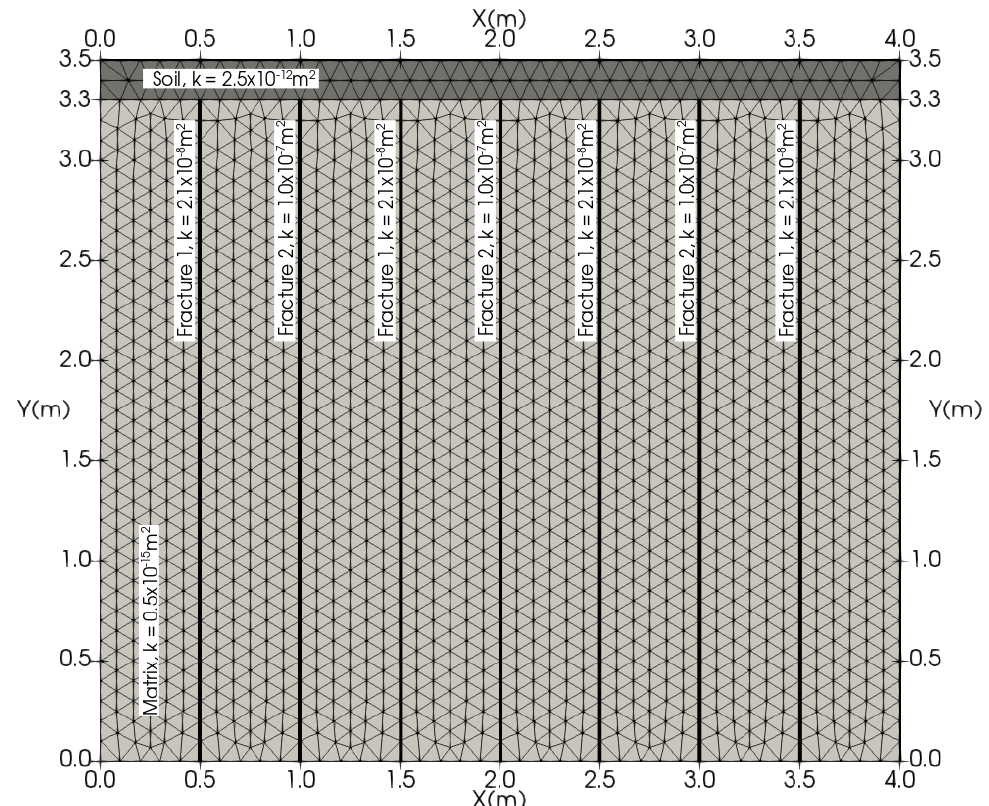
Figure 6. Model TUFF2D, a two-dimensional model of fractured tuff and its discretisation by a triangular finite-element mesh. Split boundaries were inserted between the soil layer at the top and the fractured tuff below as well as at the fracture–matrix interfaces. Collocated finite volume mesh not shown.